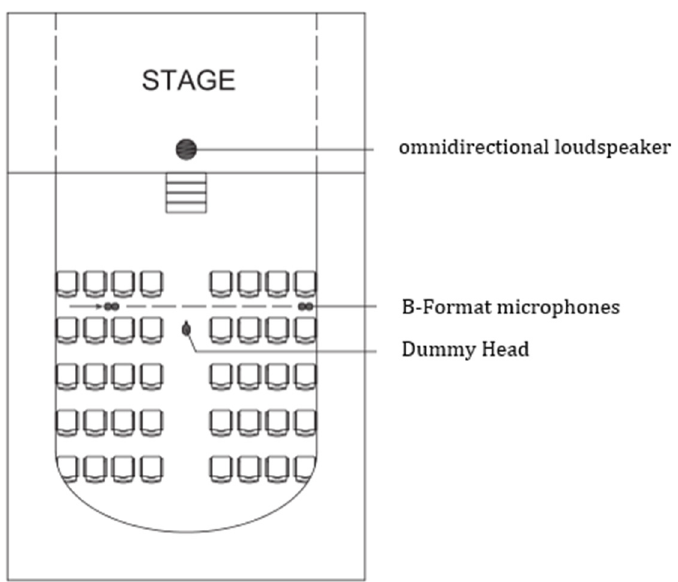
Figure 8. Plan of 1763 theatre: position of microphones for the acoustic measurements.